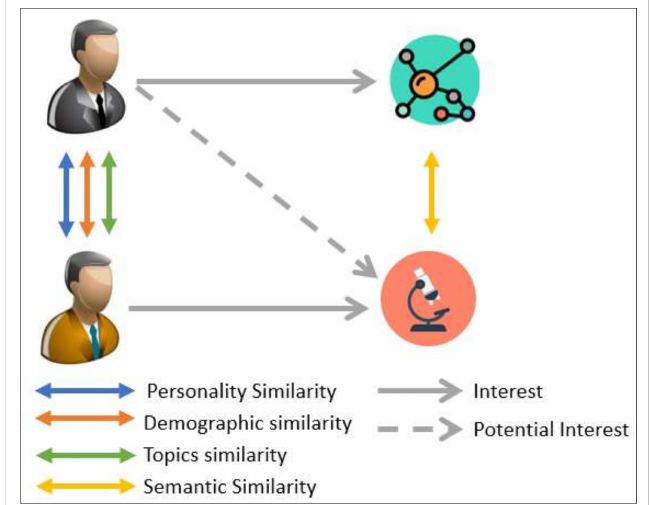
Figure 2. Proposed Approach to Find Similar Users and Topics.